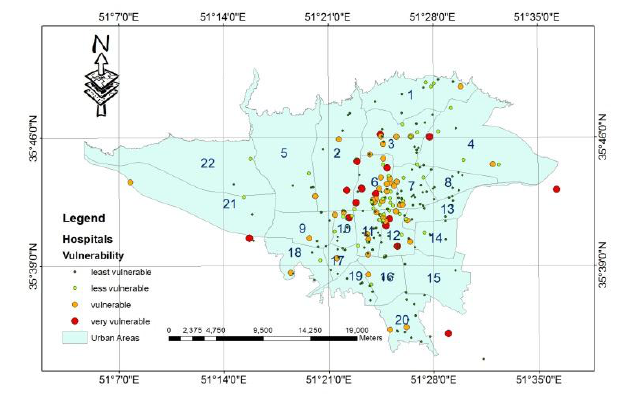
Figure 3. Vulnerability map of hospital